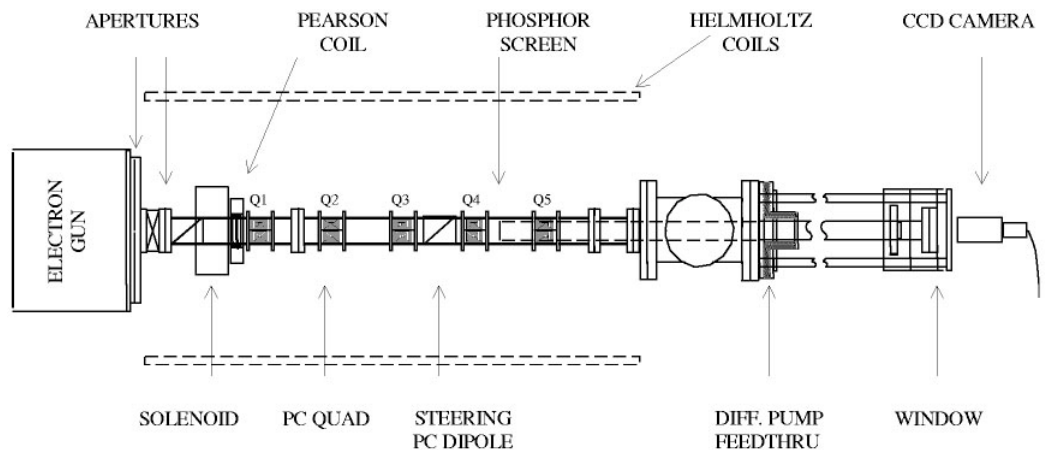
FIG. 1. Experiment setup. The PC quadrupole spacing is 15